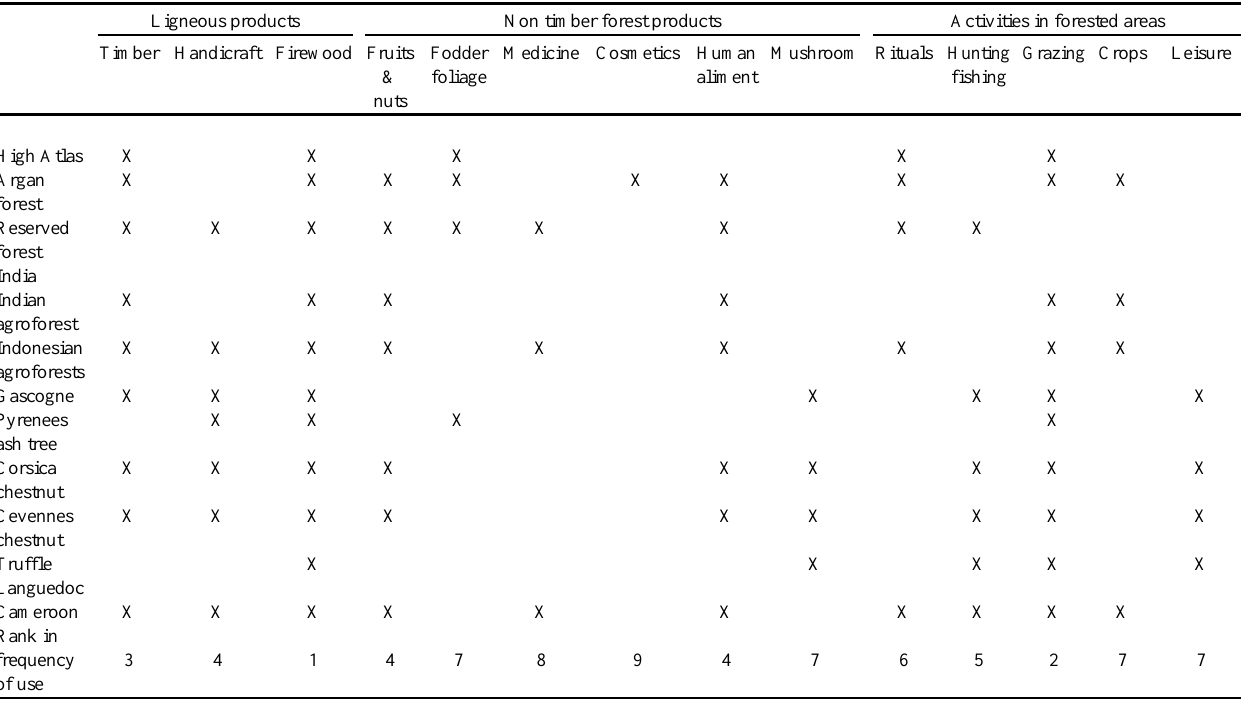
Table 3 . Diversity of uses in the 11 rural forests under study Ligneous products Non timber forest products Activities in forested